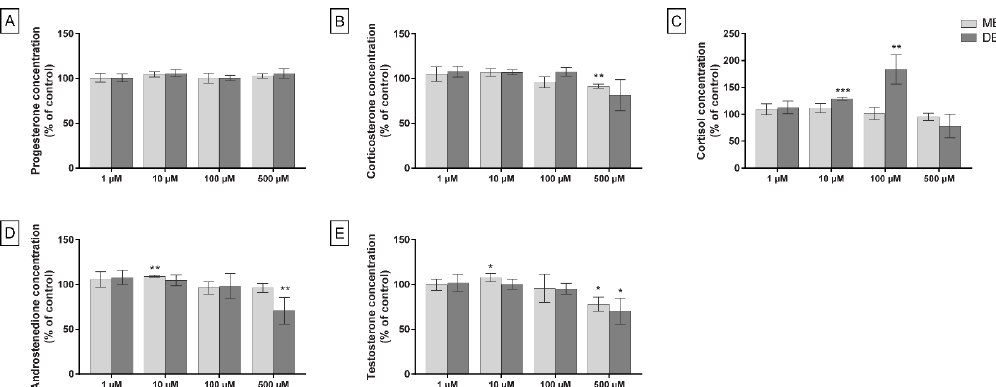
Figure 3. H295R cells exposed to DBP, MBP, or solvent control (0.1% DMSO) for 48 h show altered levels of steroid hormones. Levels of progesterone ( A ), corticosterone ( B ), cortisol ( C ), androstenedi- one ( D ) and testosterone ( E ) were measured in the cell medium by LC-MS. Values represent mean ± S.D. calculated as % of control for three replicates, where the average of six wells/treatment was calculated for each replicate. Statistically significant differences from a theoretical mean of 100 are indicated as follows: * p < 0.05, ** p < 0.01, *** p < 0.001 (One Sample t -test).